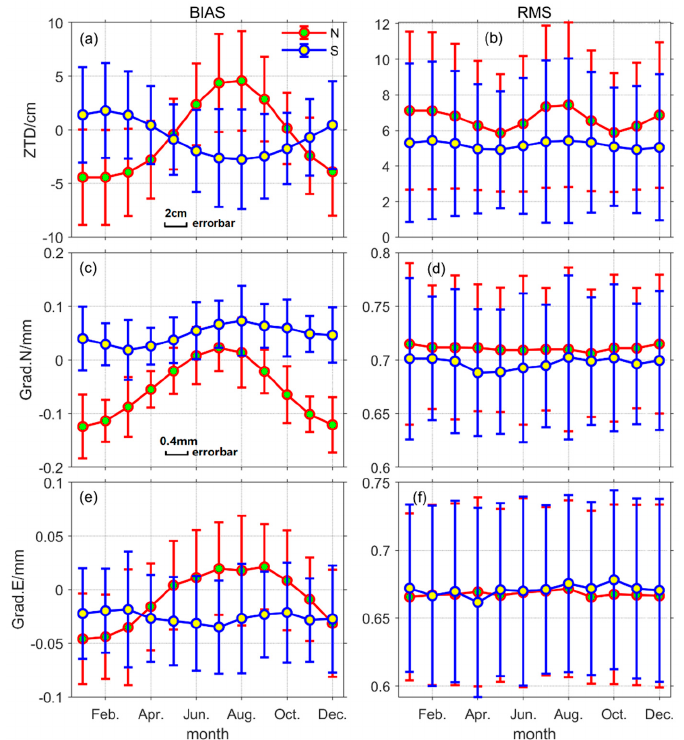
Figure 3. Average monthly BIAS ( a , c , e ) and RMS ( b , d , f ) values of zenith troposphere delay derived from GPT3 (Global Pressure and Temperature series model), north gradient and east gradient in the northern (green) and southern (yellow) hemispheres. The error bar stands for the standard deviation (STD) of each month. (Note: ( a , b ) share the error bar scale, ( c – f ) share the error bar scale).